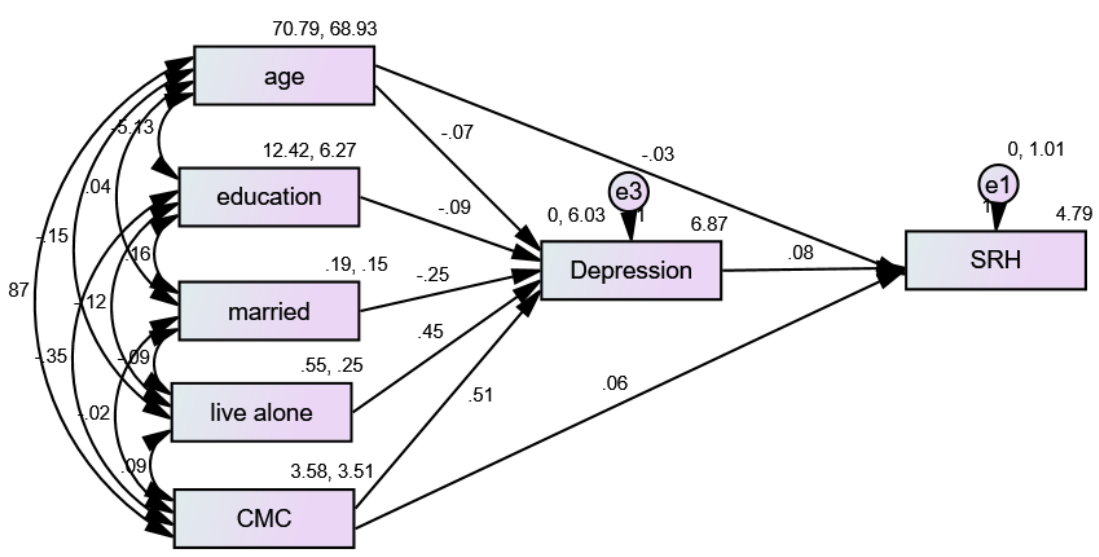
Figure 2. Summary of the Structural Equation Modeling (SEM) in African American (AA) men. Table 4. Summary of the Structural Equation Modeling (SEM) in African American (AA) men and women.